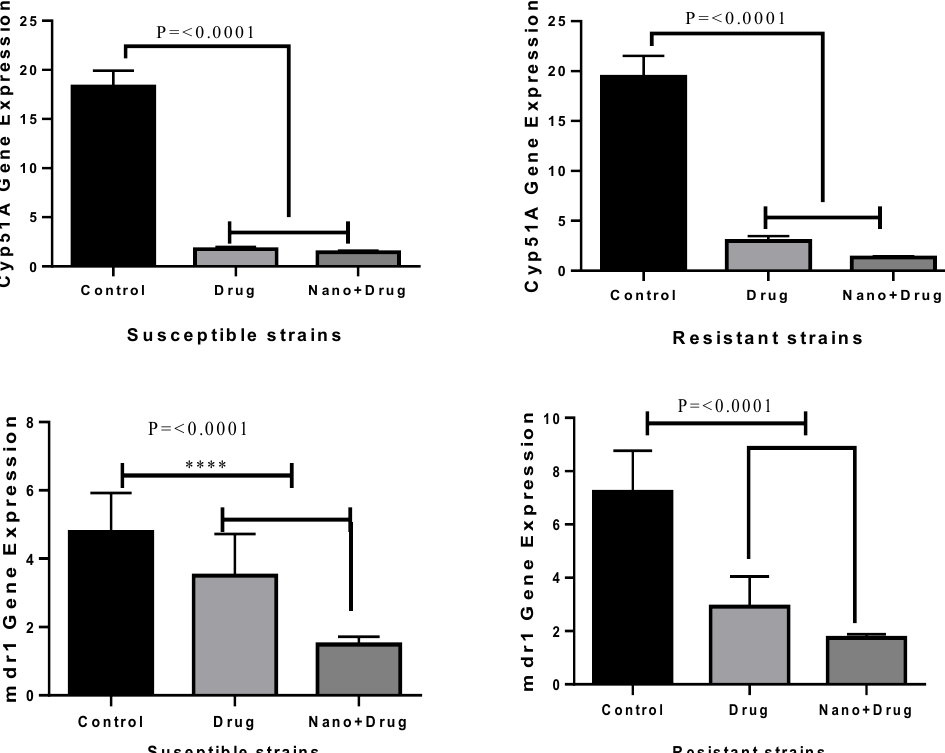
Fig. 5. After using MIC50 concentration of VCZ, the cyp51A and MDR1 gene expressions in VCZ-susceptible A. flavus strains and VCZ-resistant strains depicted a downregulation which was more pronounced in the expression of a liposomal formulation of VCZ.